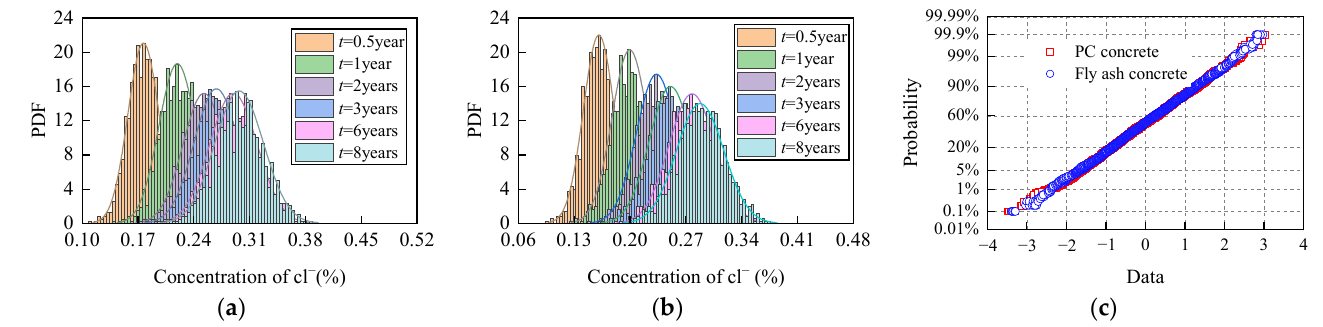
Figure 11. Probability mass functions and corresponding normal probability density distribution models for chloride ion concentration at 10 mm from concrete surface under different corrosion time: ( a ) PC concrete; ( b ) fly ash concrete; ( c ) the test analysis results after standardization. It is observed that chloride ion concentration PDF at different corrosion times is bell-